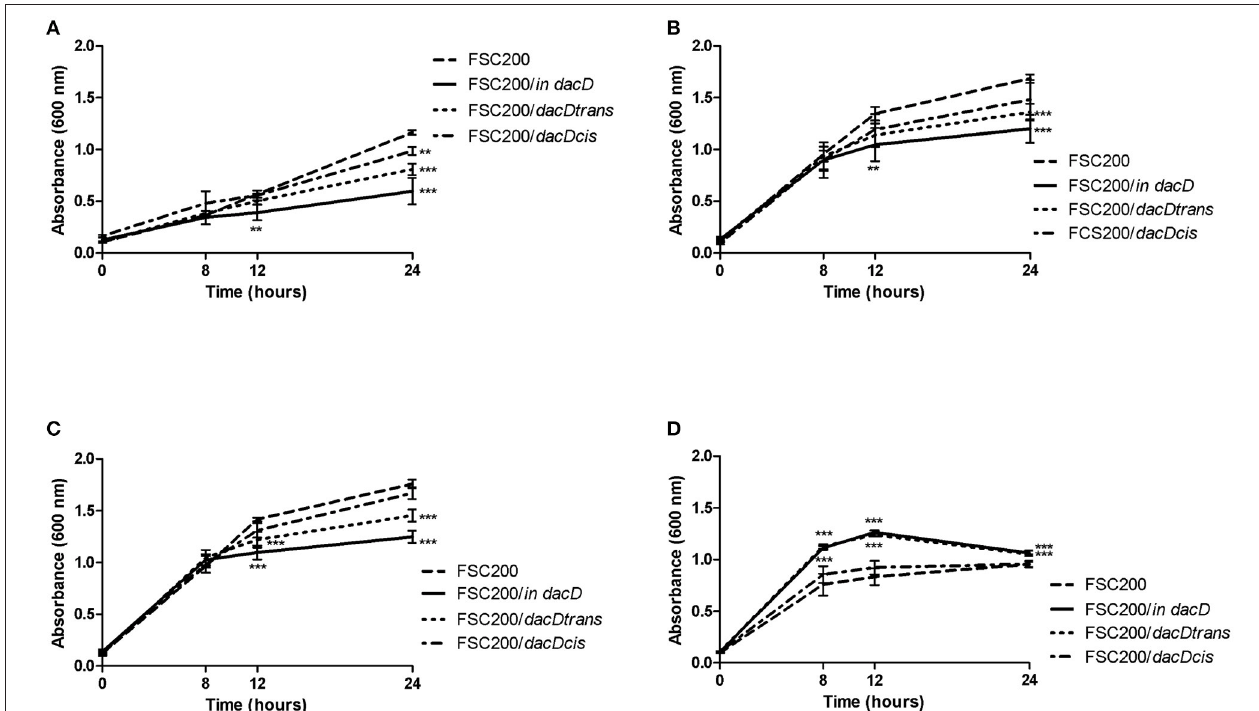
FIGURE 5 | Stress growth kinetics. F. tularensis strains were cultivated in altered Chamberlain medium (CMH) to simulate various stress conditions and the growth kinetics was determined by measuring the OD 600 using microplate reader FLUOstar Optima (BMG Labtech) for 24h. (A) Growth in CHM supplemented with 2%